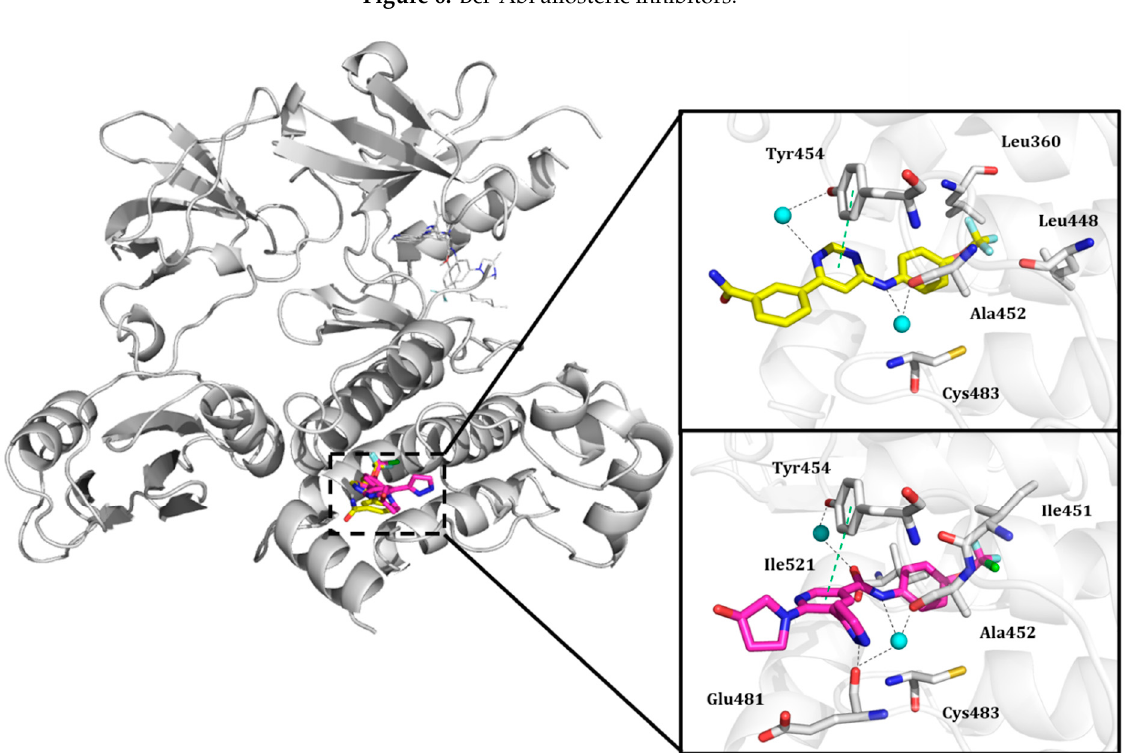
Figure 7. Details of the molecular interactions between GNF-2 and ABL001 and the myristate binding pocket reported in the top and bottom zoom-in views, respectively. The key residues are reported in sticky representation. The water bridge molecules are shown as cyan spheres. Black and green dashed lines indicate hydrogen bonds and π - π interactions,